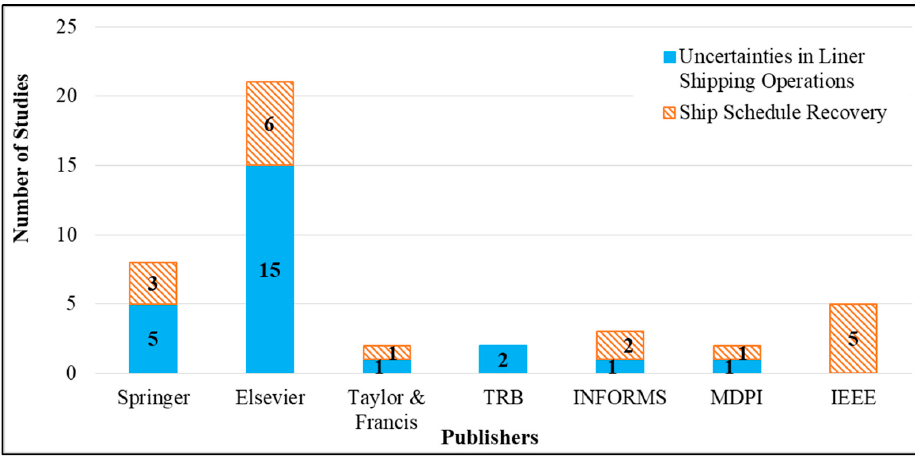
Figure 3. Distribution of the collected studies by publisher.